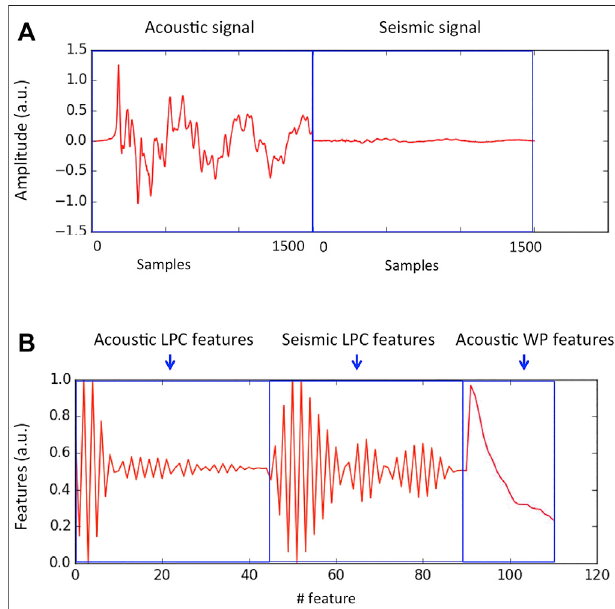
FIGURE 6 | (A) Acoustic and seismic signals of an experimental event; (B) input vector with the features extracted from the acoustic and seismic